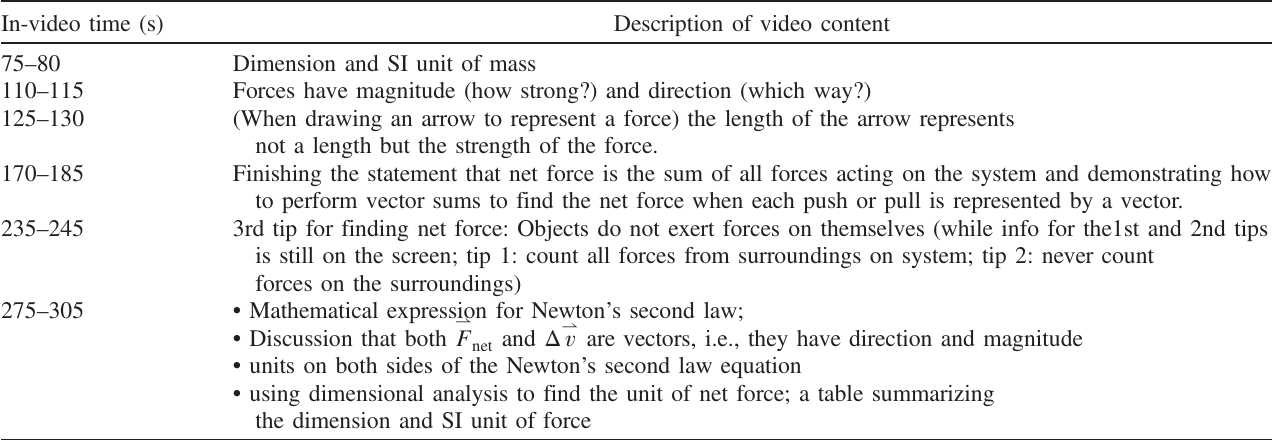
TABLE VII. Description of the video content that corresponds to the major pause peaks in Fig. 7. In-video time